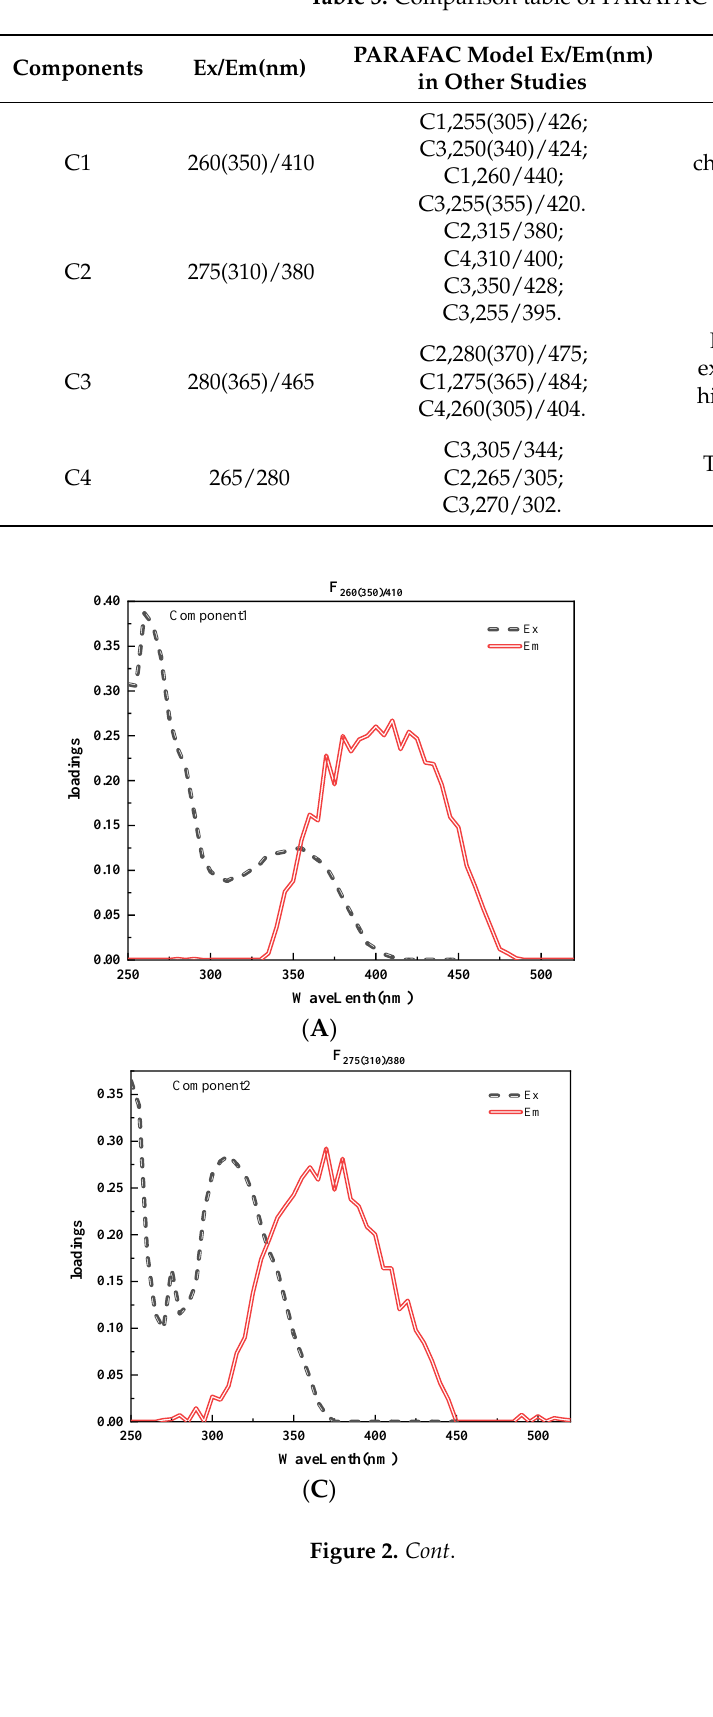
Table 3. Comparison table of PARAFAC model components.